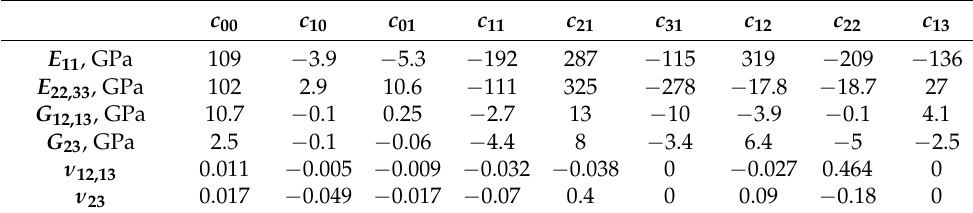
Table 1. The values of coefficients of approximation polynomial for stiffness